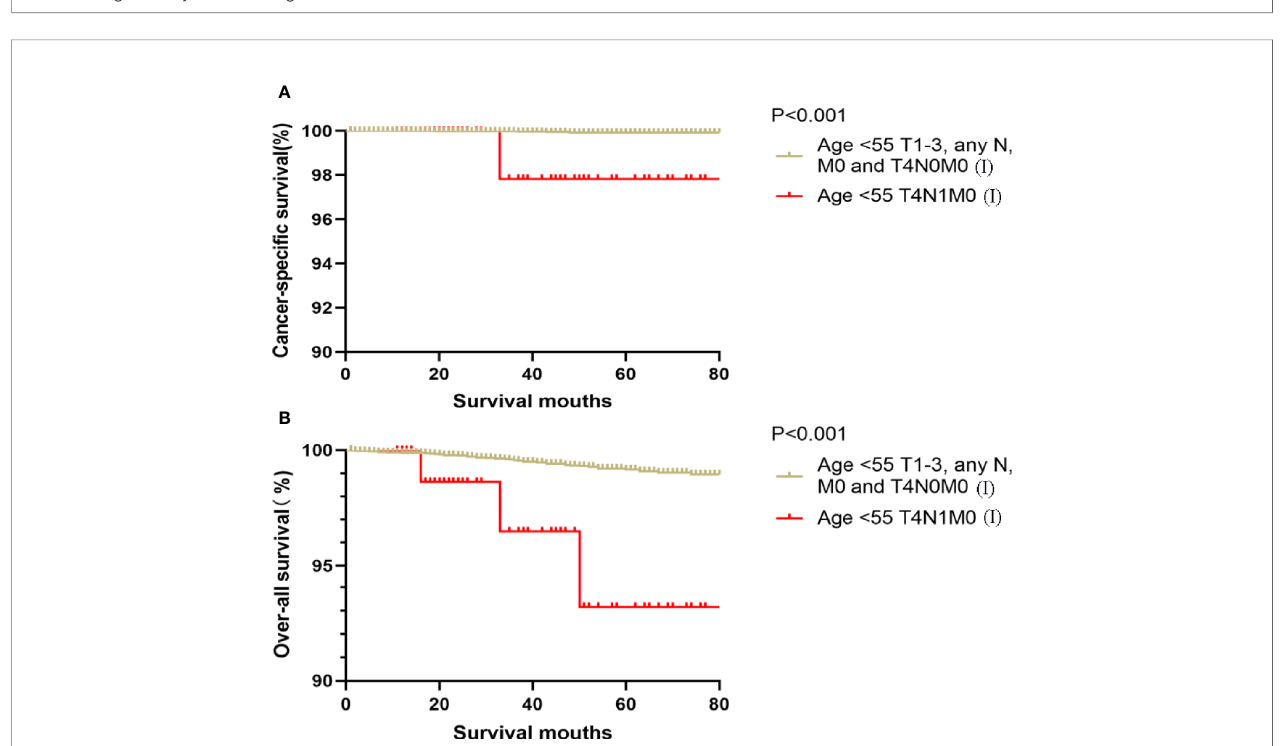
FIGURE 2 | Kaplan – Meier curves for cancer-speci fi c survival (A) and overall survival (B) between FVPTC patients aged <55 years with stage T1-3, any N, M0 or T4N0M0 disease and patients aged <55 years with stage T4N1M0